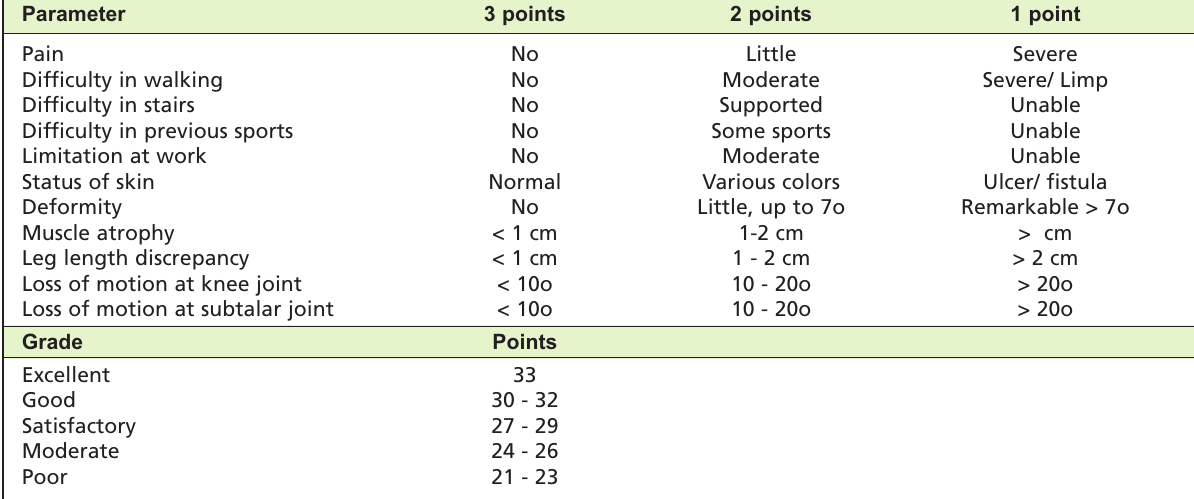
Karlstrom Olerud Score evaluating the results in points Table I: